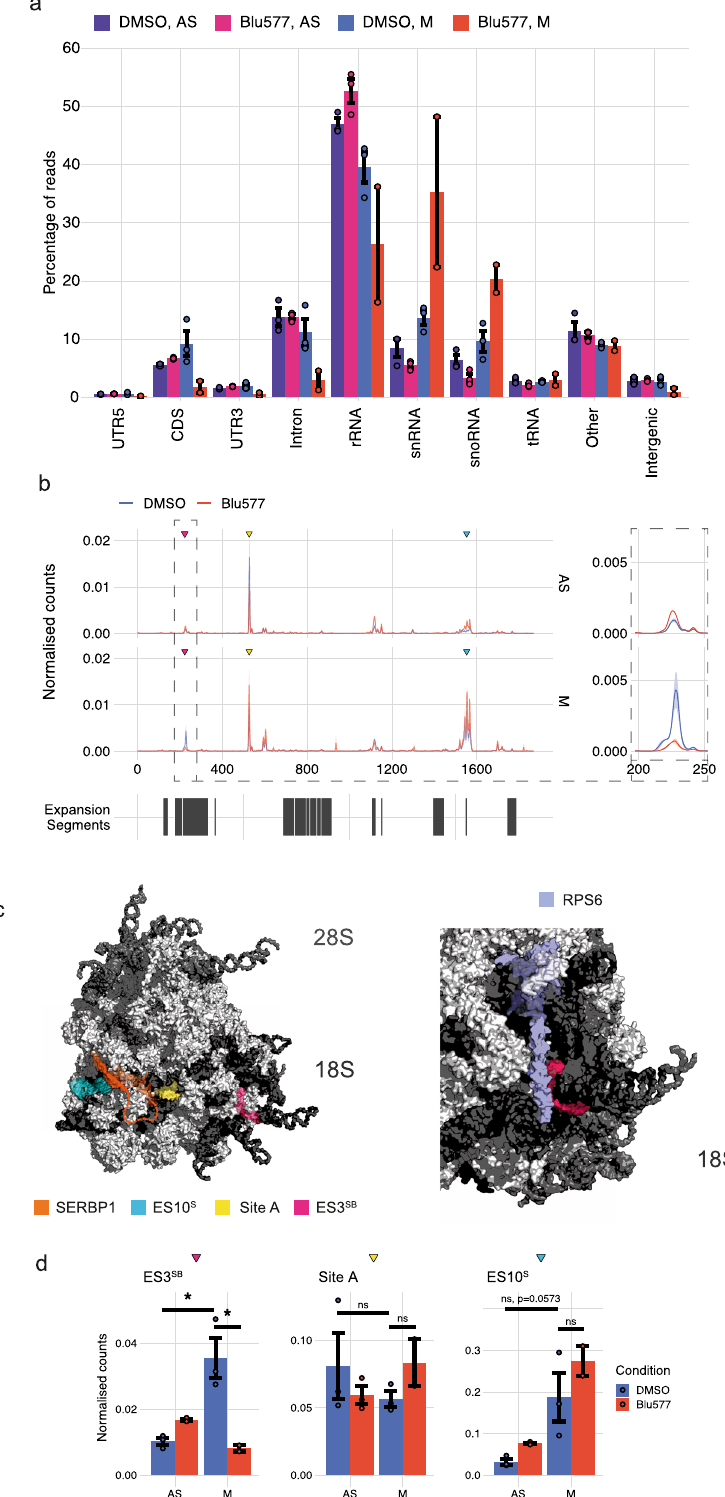
SERBP1 was validated as a PKC ε target in vitro, as demon- strated by the phosphorylation of SERBP1 by recombinant PKC ε and the identi fi cation of S74 as the dominant phosphorylation site. This phosphorylation was con fi rmed on co-expression in cells. We described a previously unreported localisation and requirement for SERBP1, which accumulates in granules exclu- sively in mitosis (M-bodies). RNA degradation induced by RNase